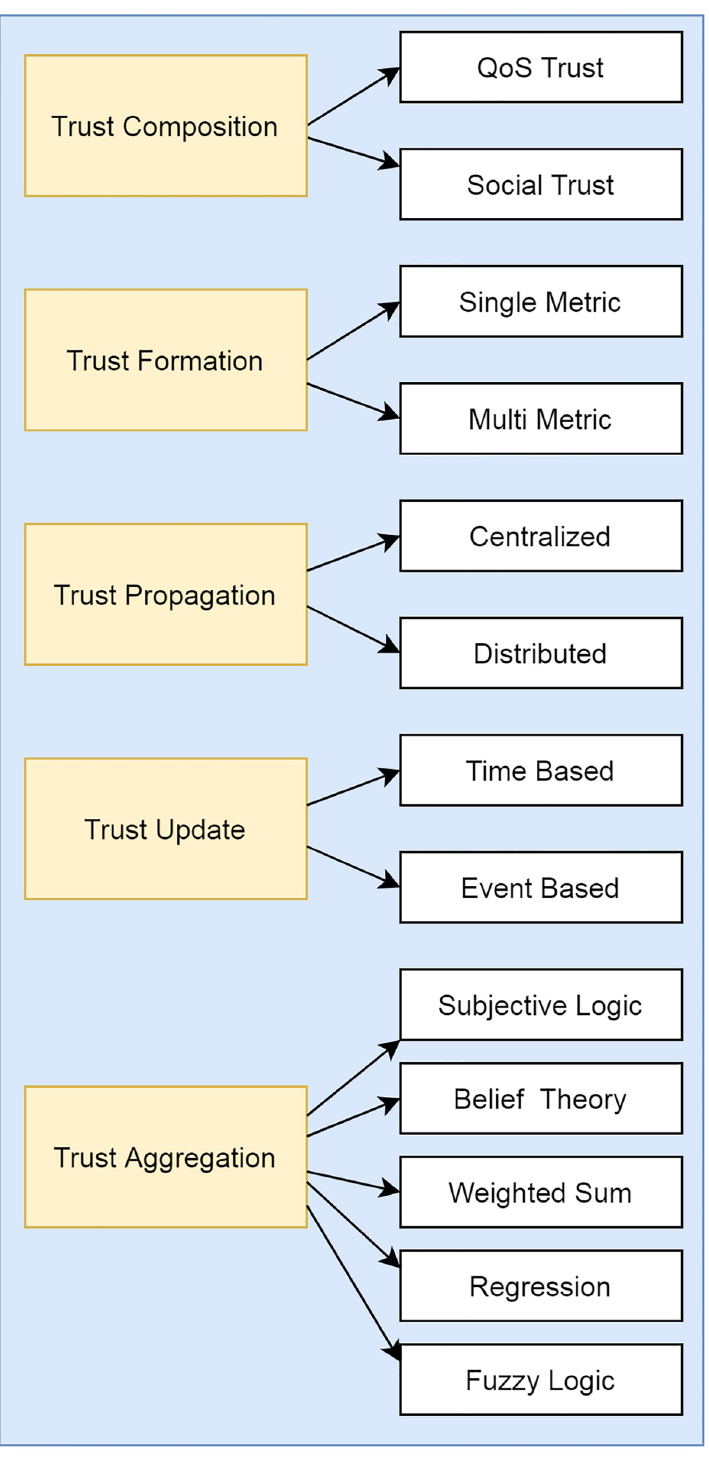
Fig 6. Sybil attack in